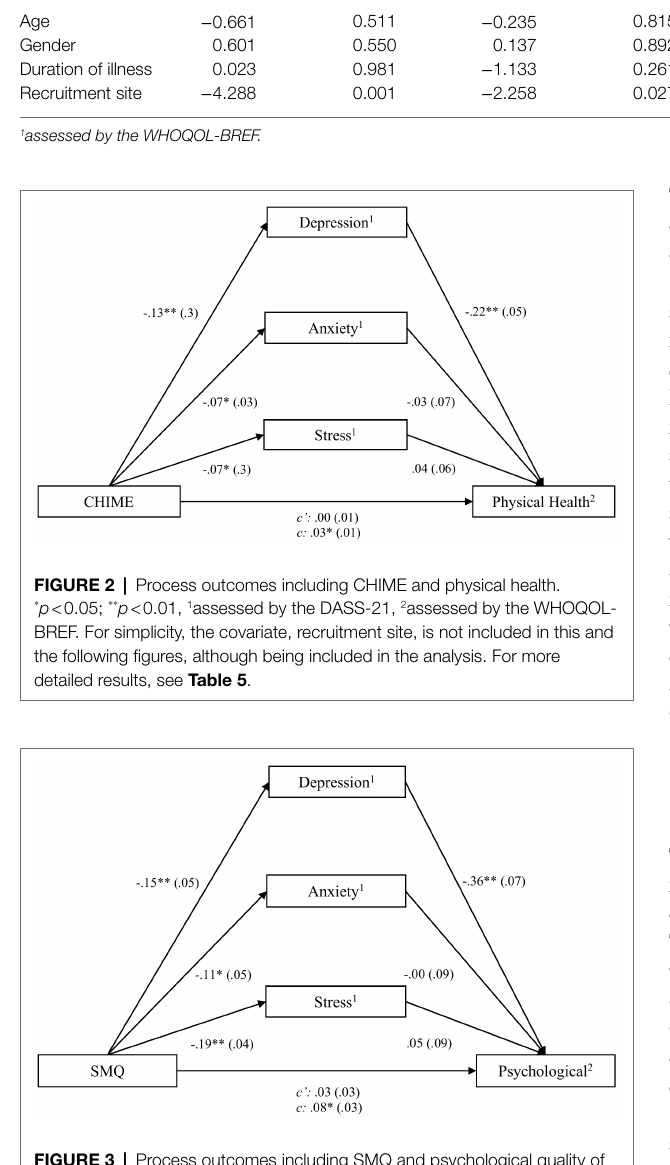
FIGURE 3 | Process outcomes including SMQ and psychological quality of life. * p < 0.05; ** p < 0.01, 1 assessed by the DASS, 2 assessed by the WHOQOL-BREF.